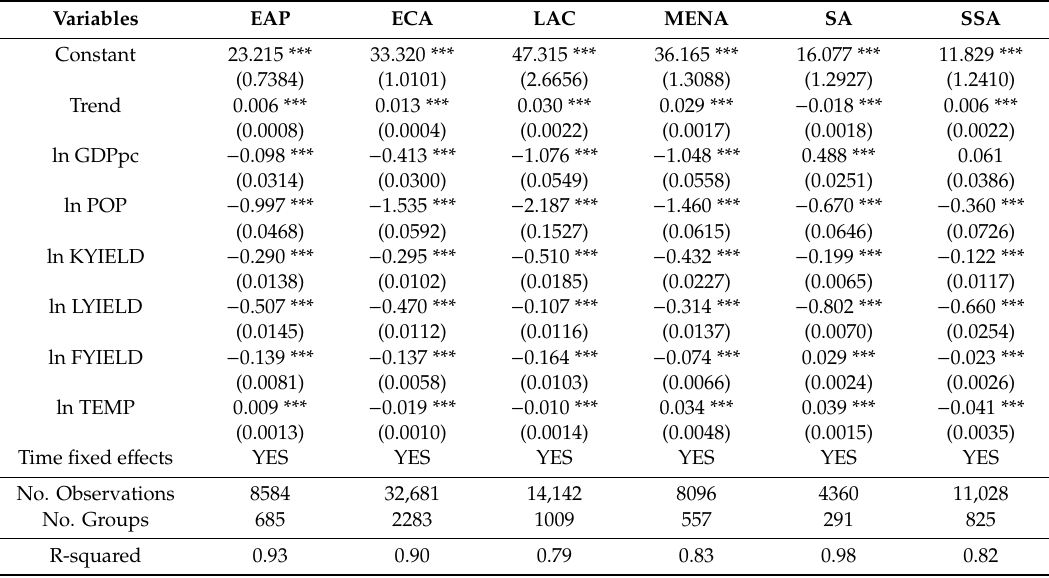
Table 4. Estimation results of model M4 by geographical